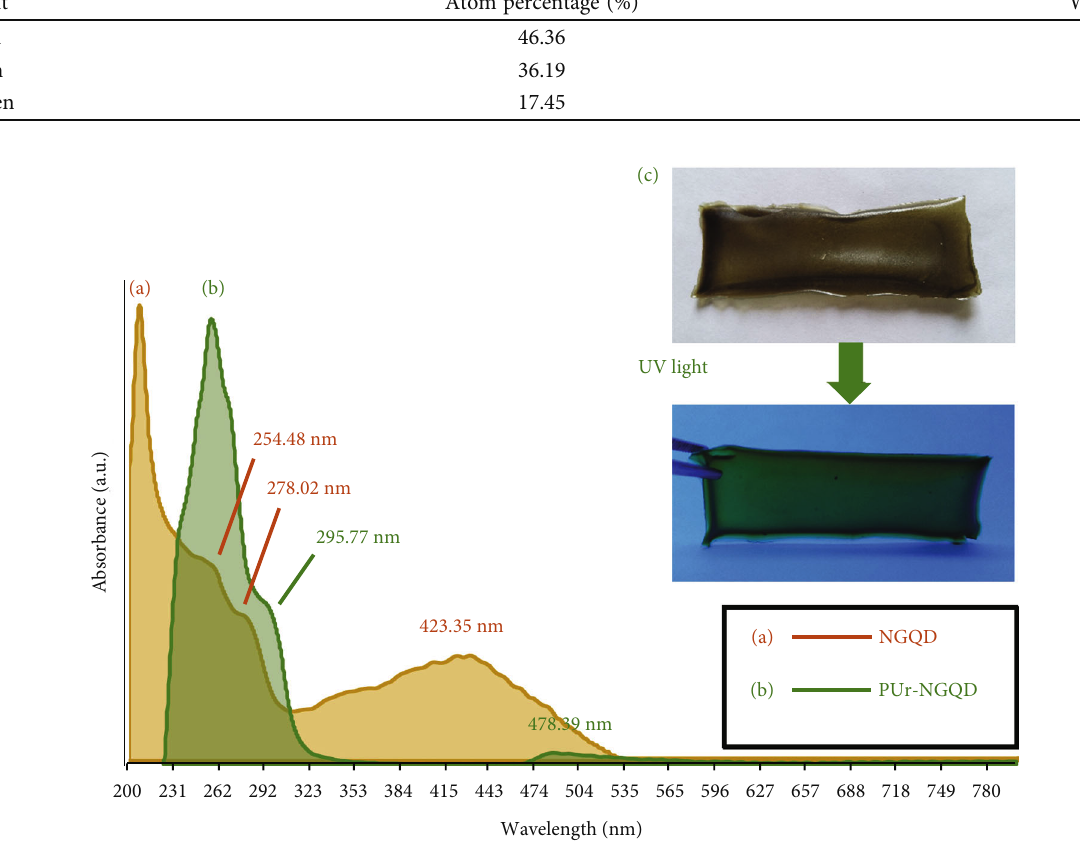
Figure 7: UV-vis spectra. (a) NGQD, (b) PUr-NGQD, and (c) PUr-NGQD image in UV light.